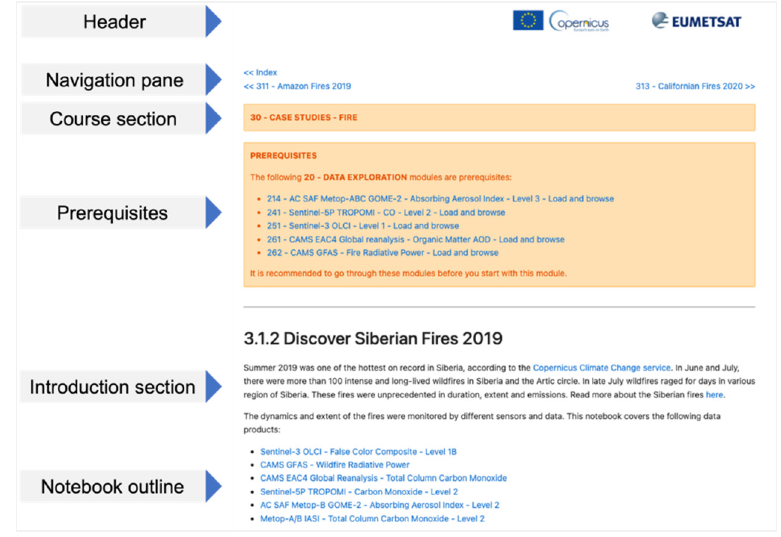
Figure 4. Example of one case study notebook of the LTPy main course, with several instructional design elements integrated: header, navigation pane, alert boxes (course section and prerequisites), introduction section and notebook outline with anchor links. Table 4. Overview of useful HTML/Markdown commands, including their functionality and the objective they